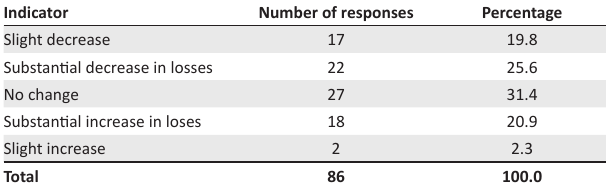
TABLE 6: Changes in disaster losses over the last 5 years.